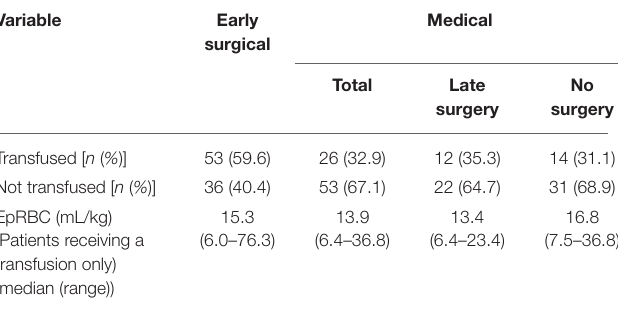
TABLE 5 | Transfusion requirements between “early surgical” ( n = 89) and “medical” ( n = 79) groups. Variable Early